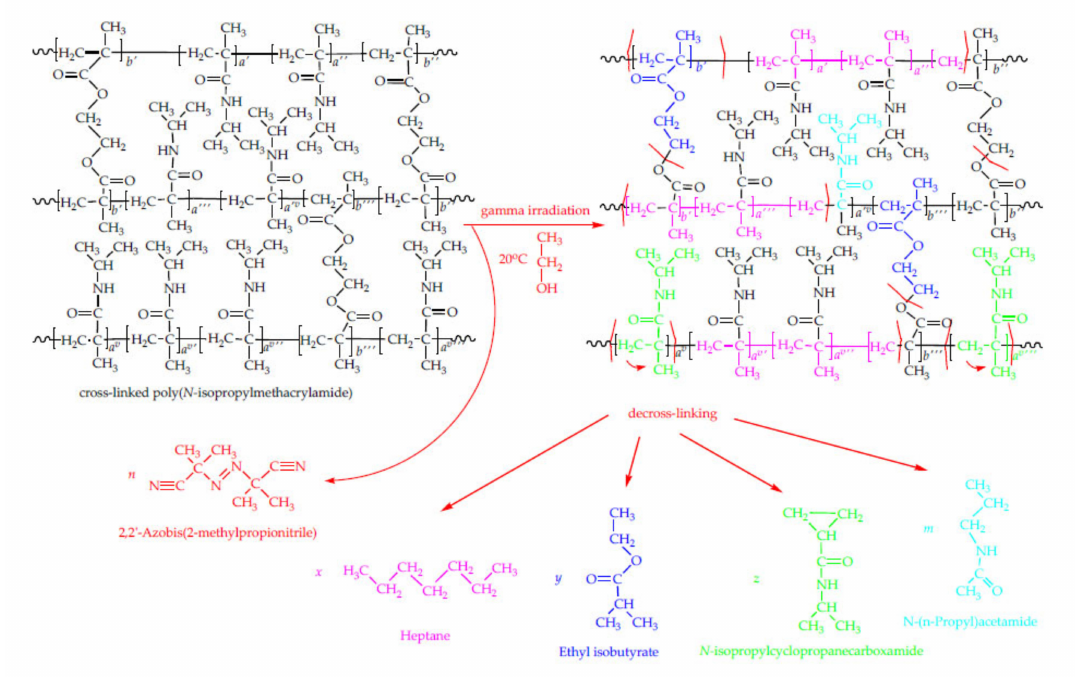
Figure 10. Potential pathways for the γ -irradiation-induced decomposition of the p( N iPMAm) hydrogels with the chemical structures of the major